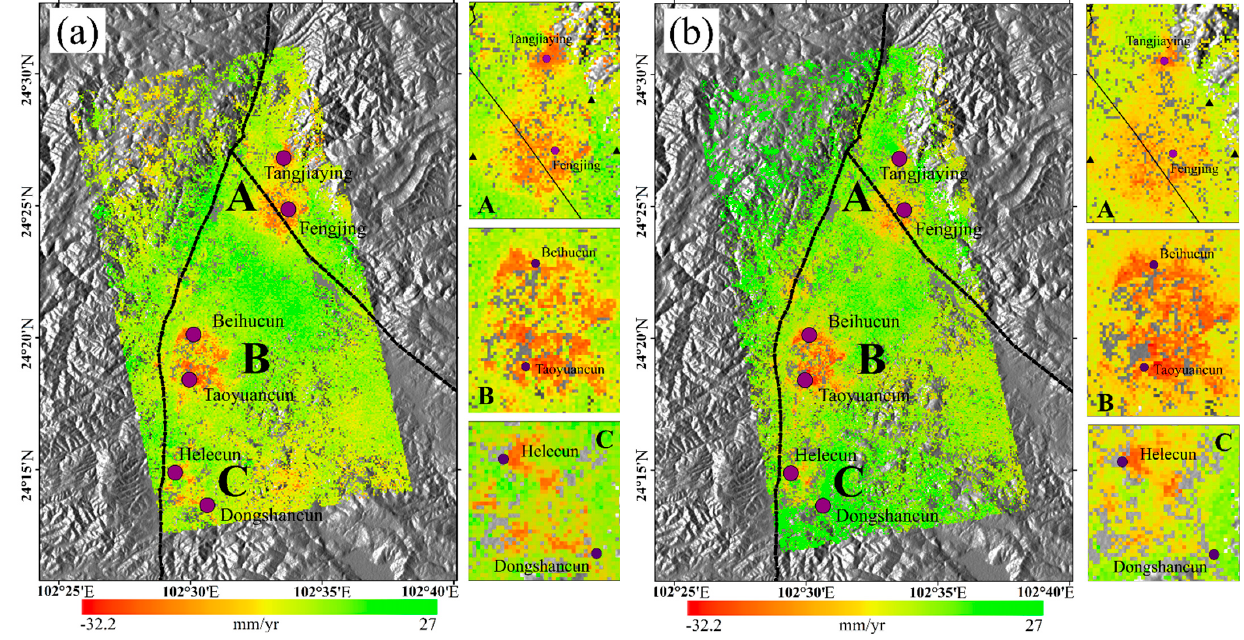
Figure 9. Results for the vertical deformation velocity obtained from the Radarsat-2 and Sentinel-1A. Black triangles indicate the location of the leveling points; purple circles indicate subsidence villages. Black dashed lines indicate faults. ( a ) Vertical deformation velocity generated by Radarsat-2. ( b ) Vertical deformation velocity generated by Sentinel-1A.